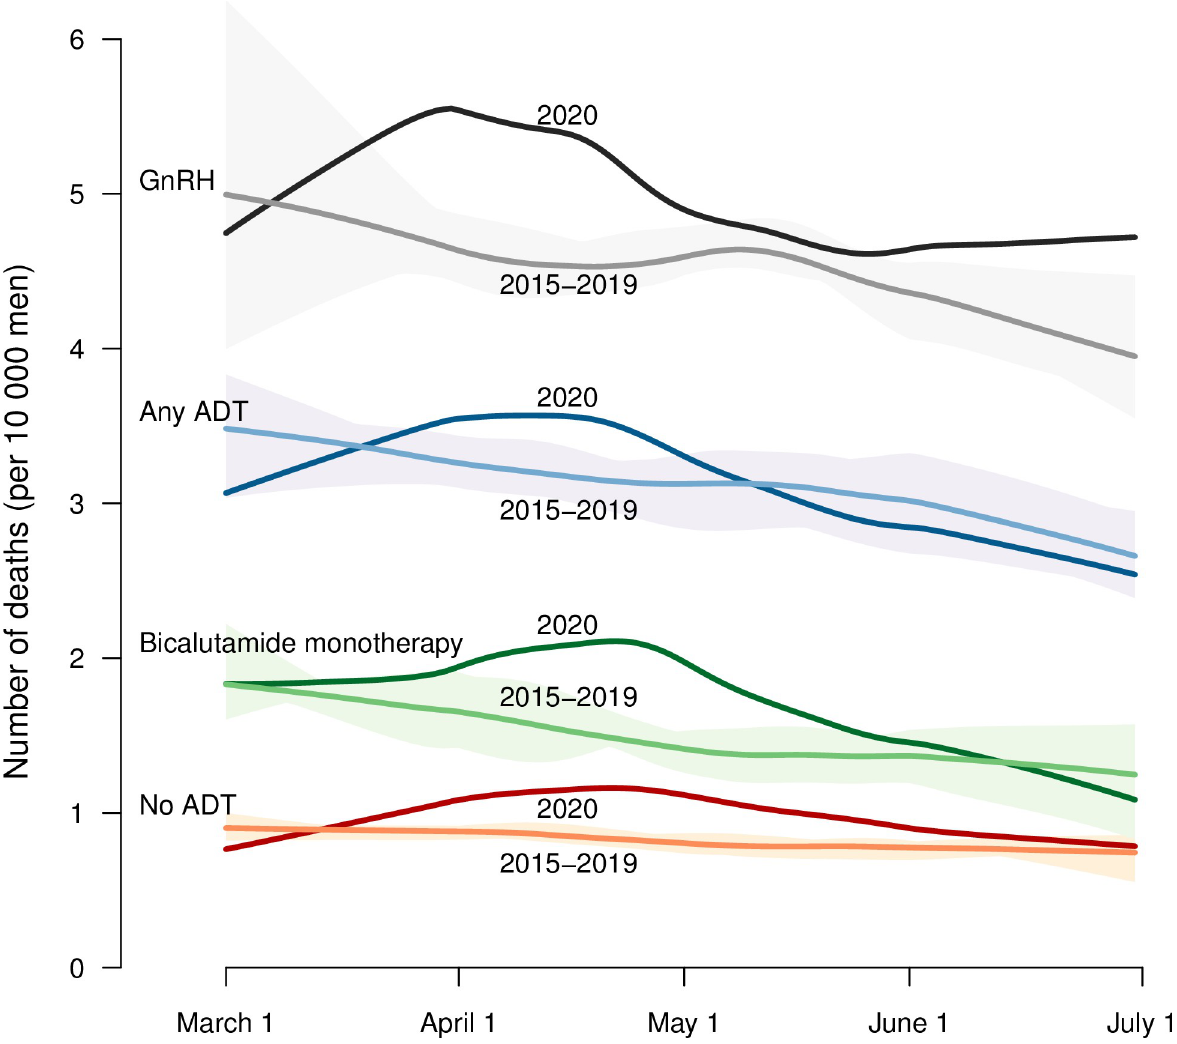
Fig 2. All-cause mortality in men with prostate cancer in March to June 2020 compared to the mean for corresponding months in 2015–2019. Data are presented for men not on androgen deprivation therapy (ADT), men on any ADT, men on bicalutamide monotherapy, and men on GnRH, including GnRH agonists and men who underwent bilateral orchidectomy. The number of deaths by calendar day per 10,000 men with prostate cancer at risk was plotted using loess smoothing. The shaded areas illustrate the range of mortality rates for the separate years 2015 to 2019.